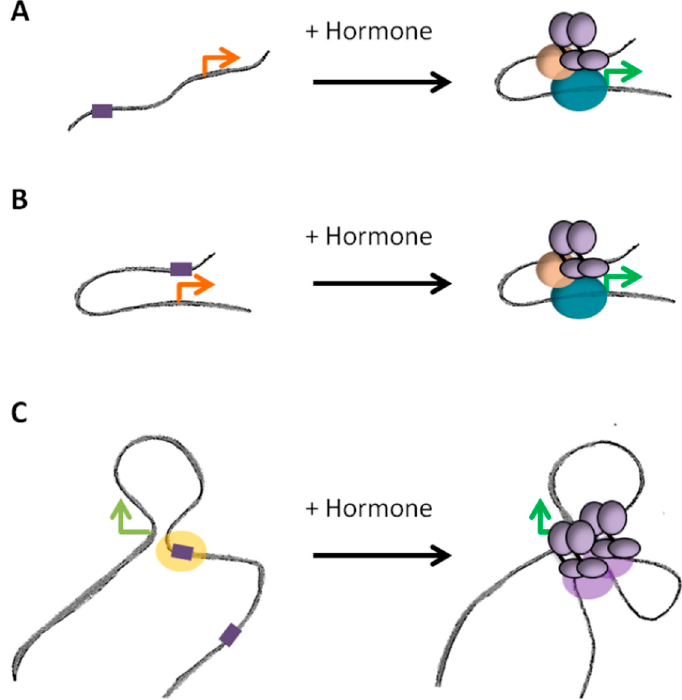
Figure 4. Different dynamics of promoter-enhancer looping. ( A ) Binding of the receptors upon exposure to the hormone induces the formation of loop between promoter and enhancer in an active process. ( B ) In other cases, the loop is established prior binding of the receptors, which activate the enhancer region in an already favorable conformation. ( C ) A promoter could be regulated by several enhancers, which require or not de novo chromatin looping. Binding of steroid receptors in the absence of hormones (unliganded receptors) might serve in maintaining such structures prior exposure to the hormone. Orange and green arrows correspond to paused or activated promoters, respectively.